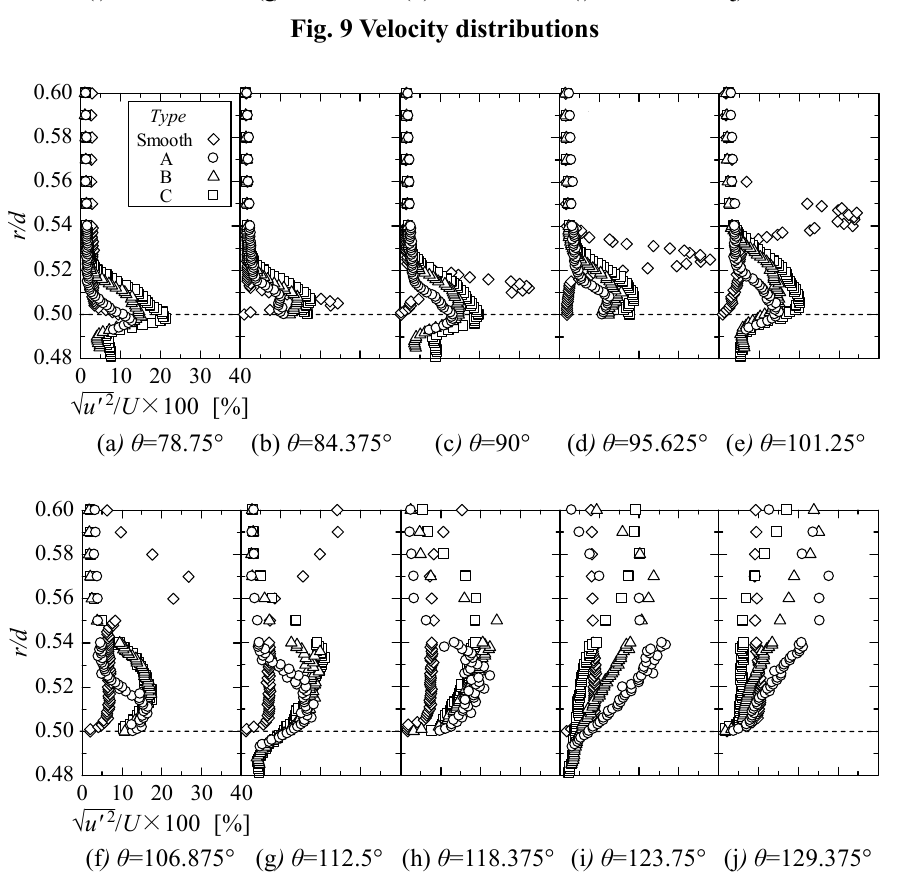
Fig. 10 Turbulent intensity